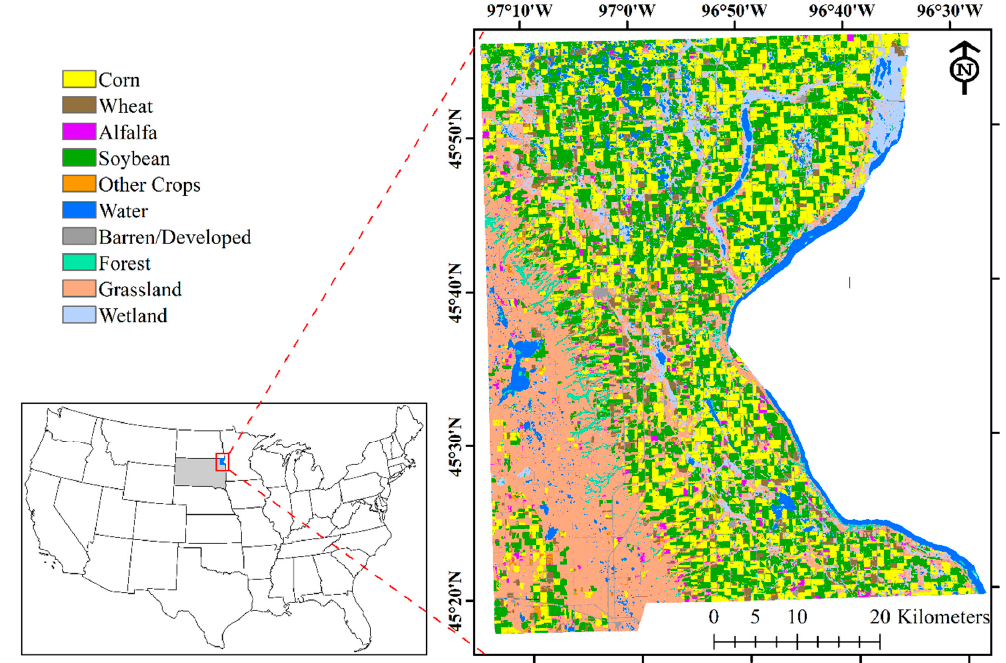
Figure 1. The 2016 reclassified Cropland Data Layer for Roberts County, South Dakota.